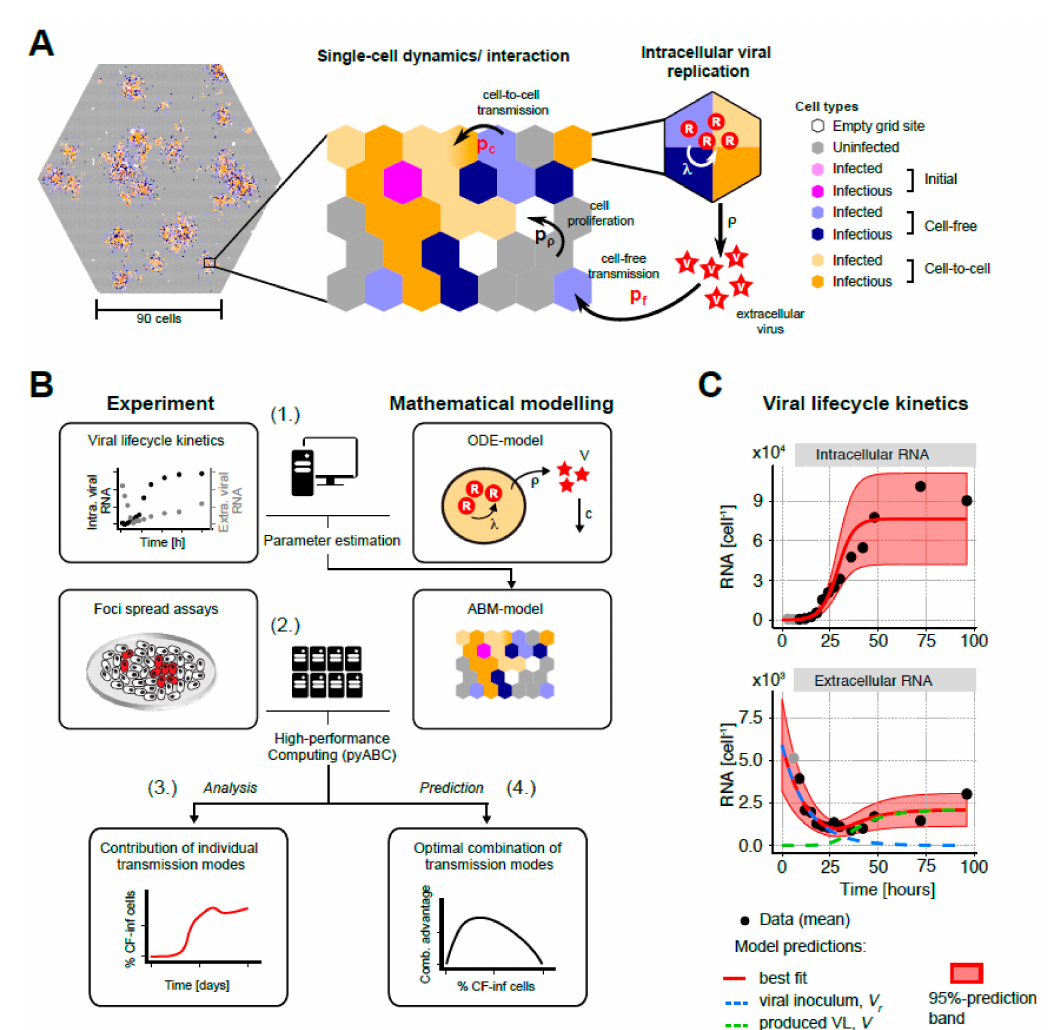
Figure 3. A multi-scale agent-based model to describe HCVcc spread assay dynamics: ( A ) Schematic of the agent-based model showing the multi-level structure considering single-cell and intracellular viral replication dynamics when simulating HCV spread. Individual cells are distributed on a hexagonal grid (left), which represents parts of the in vitro culture system. These uninfected cells are able to proliferate to fill empty grid sites with probability p p . Starting from a number of initially infected cells, uninfected cells can get infected by cell-free or cell-to-cell transmission by stochastic processes according to the probabilities p f and p c , that depend on the extracellular viral concentration, V , or the intracellular viral load, R , of infectious cells, respectively. Intracellular viral replication within these cells considers the changing concentration of intracellular viral RNA, R , and viral production, ρ (right). See Section 2 for a detailed description of the different processes considered. ( B ) Sketch of the step-wise analytical approach used to infer the contribution of the different transmission modes to the HCV infection dynamics: (1.) Experimental data on viral lifecycle kinetics are combined with a mathematical model to quantify and parameterize intracellular viral replication and viral export. (2.) These results are then incorporated in the multi-scale agent-based model (ABM) that is used to simulate HCV spread dynamics under the various experimental conditions. The ABM was fitted to the time-resolved focus size distribution data with and without the use of anti-E2 using a high-performance computing approach (pyABC). (3.) The parameterization of the individual processes within the ABM to describe the observed dynamics allows us to infer the contribution of the individual transmission modes to viral spread given different scenarios. (4.) In addition, based on the obtained simulation environment, we predict the advantage of combined transmission modes for viral spread. ( C ) Experimental data (black dots) and model predictions (red line) showing the dynamics of intra- and extracellular viral RNA over time. Red-shaded area indicates the 95% prediction interval of model predictions. For the extracellular RNA (lower panel), the dashed lines indicate the contribution of the initially applied (blue) and newly produced (green) virions to the total viral